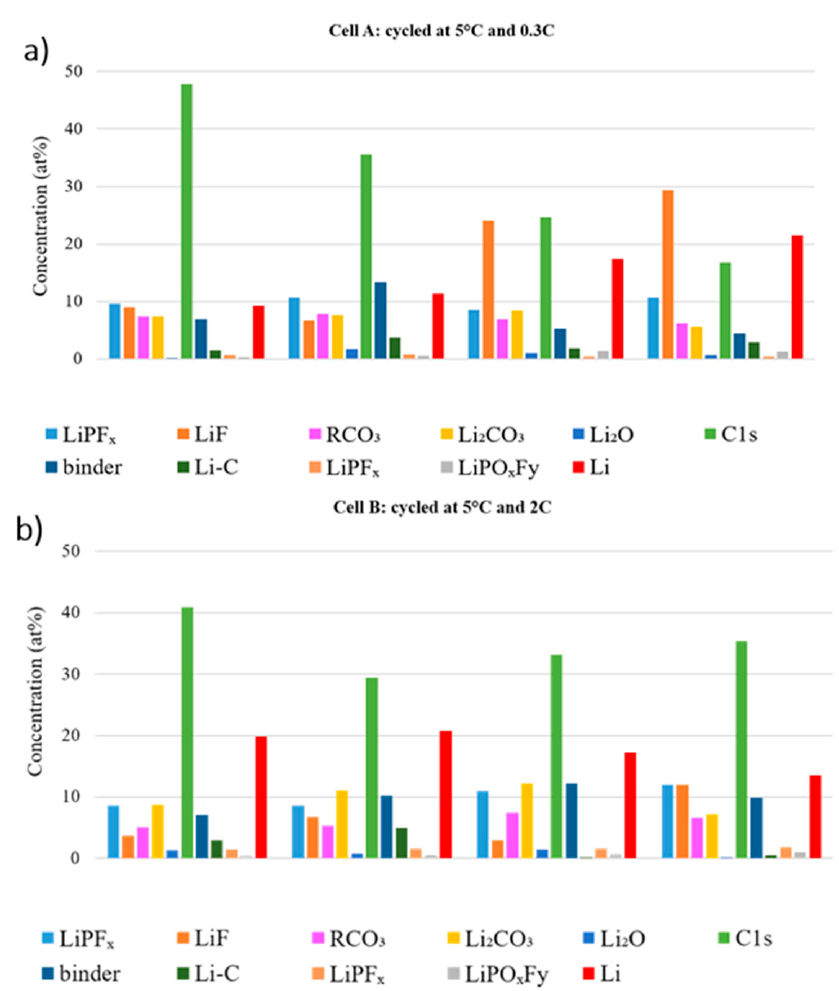
Figure 9. Atomic concentration at the center and edge of the electrode sheet in different position of the stack of ( a ) Cell A and ( b ) Cell B.